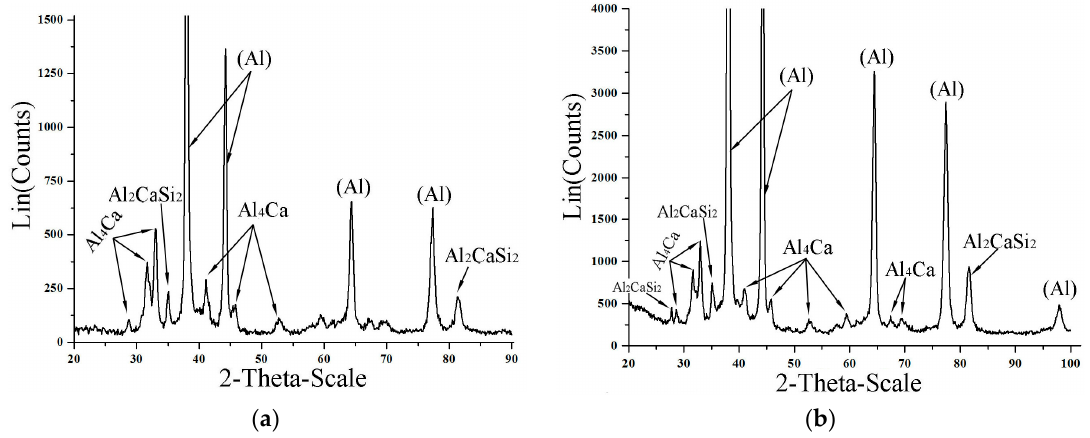
Figure 11. XRD patterns for the alloys Al10Mg10Ca2Si ( a ) and Al10Mg4Ca2Si ( b ).